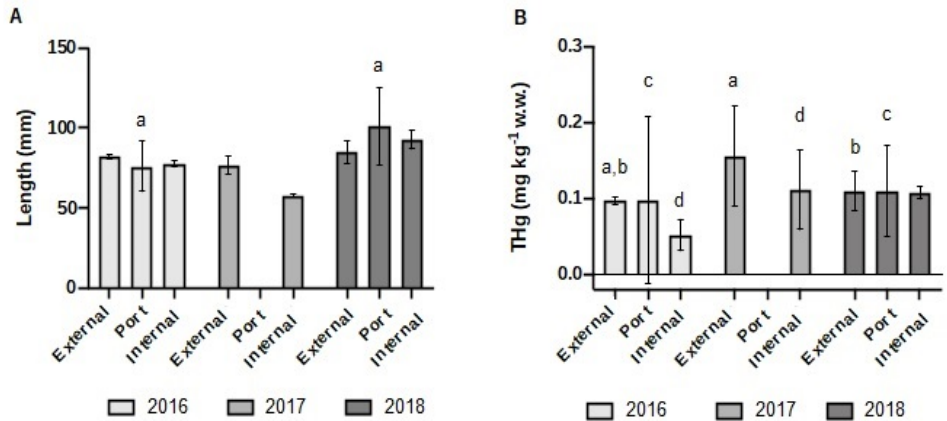
Figure 3. ( A ) Length and ( B ) THg concentrations in swimming crabs before (2016), during (2017) and after (2018) the dredging activities at the Rio de Janeiro seaport, external (Urca and Flamengo) and internal (Engenho and Paquet á ) swimming crab locations. Same letters in columns indicate statistically significant di ff erences between years.